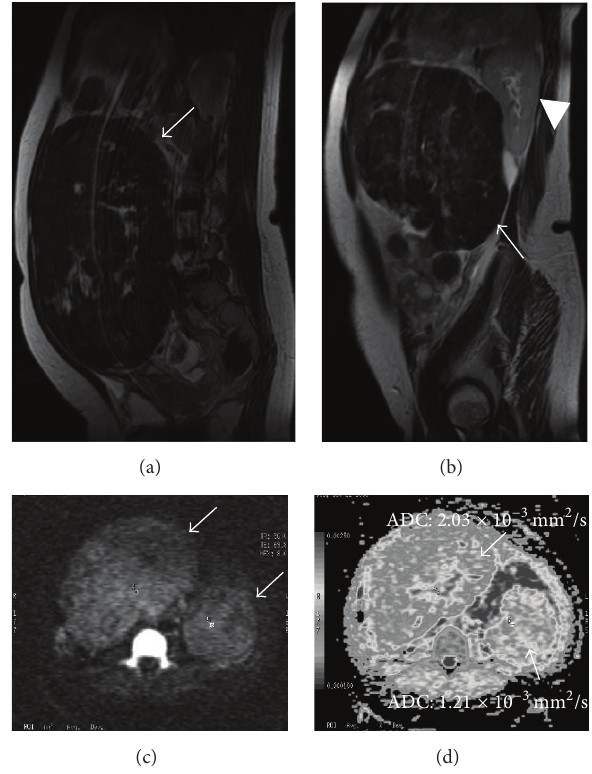
Figure 2: Two large tumors ((a–d), arrow) reached kidney ((b), arrow head). These tumors showed low intensity on T2-weighted image ((a) and (b), arrow) and intermediate intensity on diffusion- weighted image ((c), arrow). The apparent diffusion value was 2.03, 1.21 × 10 −3 mm 2 /s ((d), arrow); thus, we did not consider that these tumors were as